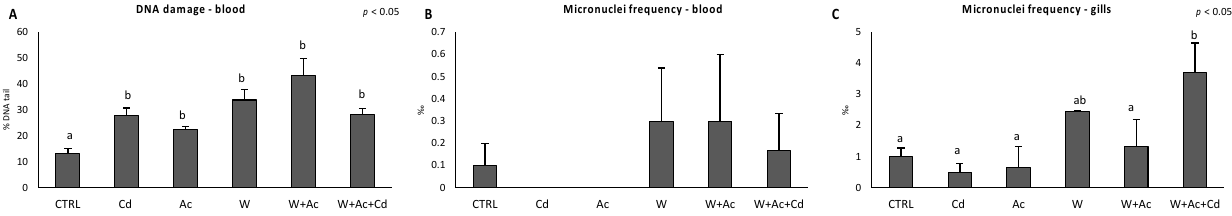
Figure 6. DNA damage and micronuclei frequency, in tissues of T. bernacchii exposed to different experimental conditions. Panels ( A ) and ( B ) blood, and ( C ) gills. Different letters highlight significant differences between groups of means. Data are expressed as mean ± standard deviations, n = 5.